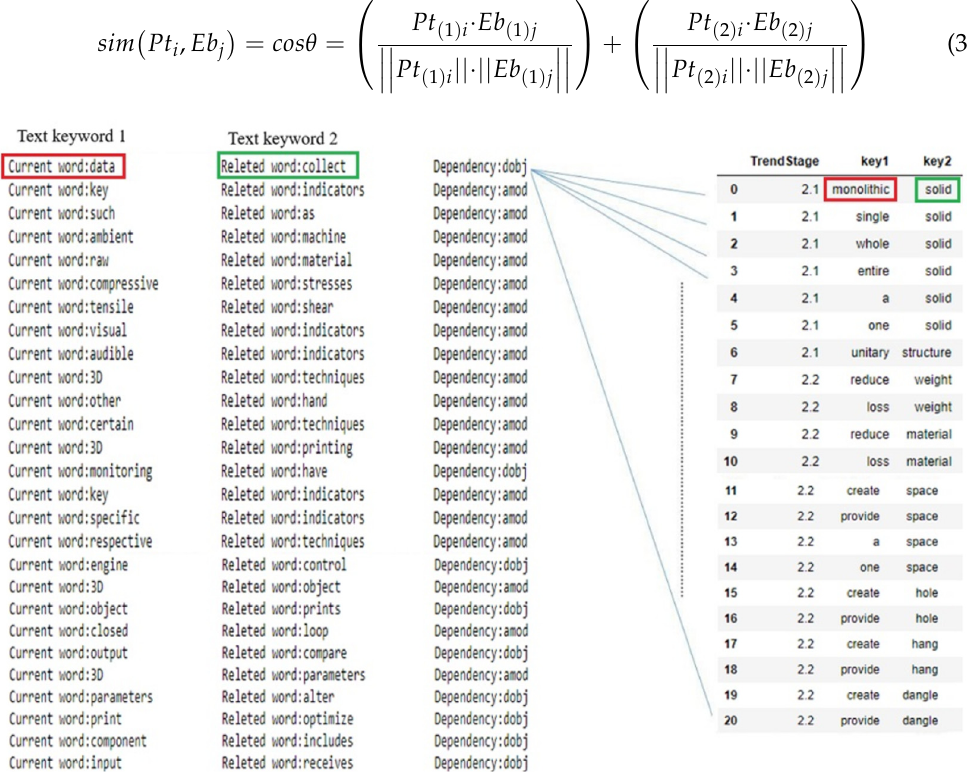
Figure 5. Calculation illustration between patent text keywords and dictionary keywords.